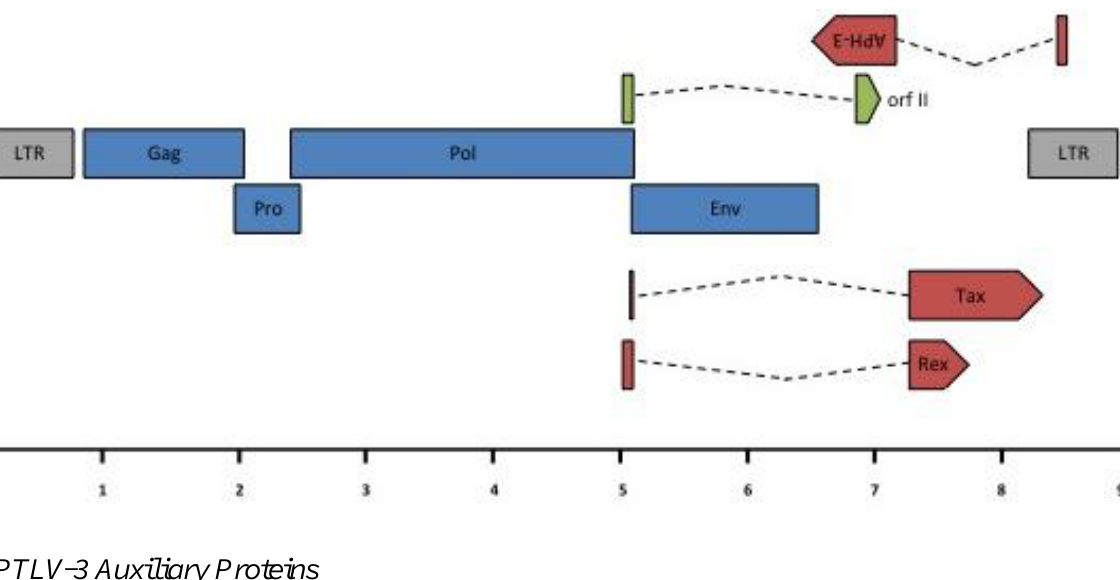
Figure 5. HTLV-3 genomic organization. HTLV-3 ORFs and transcription map. A scheme of the HTLV-3 genome, alternatively spliced mRNAs, and putative proteins encoded by each mRNA is shown. ORFs are indicated by boxes. gag , pro , pol , env , tax/rex and APH-3 transcripts were amplified from 293T cells transfected with an HTLV-3 molecular clone or from STLV-3 infected cells [24,25]. Gray: LTR; blue: structural and enzymatic viral proteins; red: regulatory proteins; green: auxiliary protein. LTR: Long Terminal Repeat; (Blue color): gag: group specific antigen; pro: protease; pol: polymerase; env: envelope; (Red color): rex: regulator of expression; tax: transactivator and APH-3: antisense protein of HTLV-3; (Green color) RorfII. Note that RorfII shares its first exon with